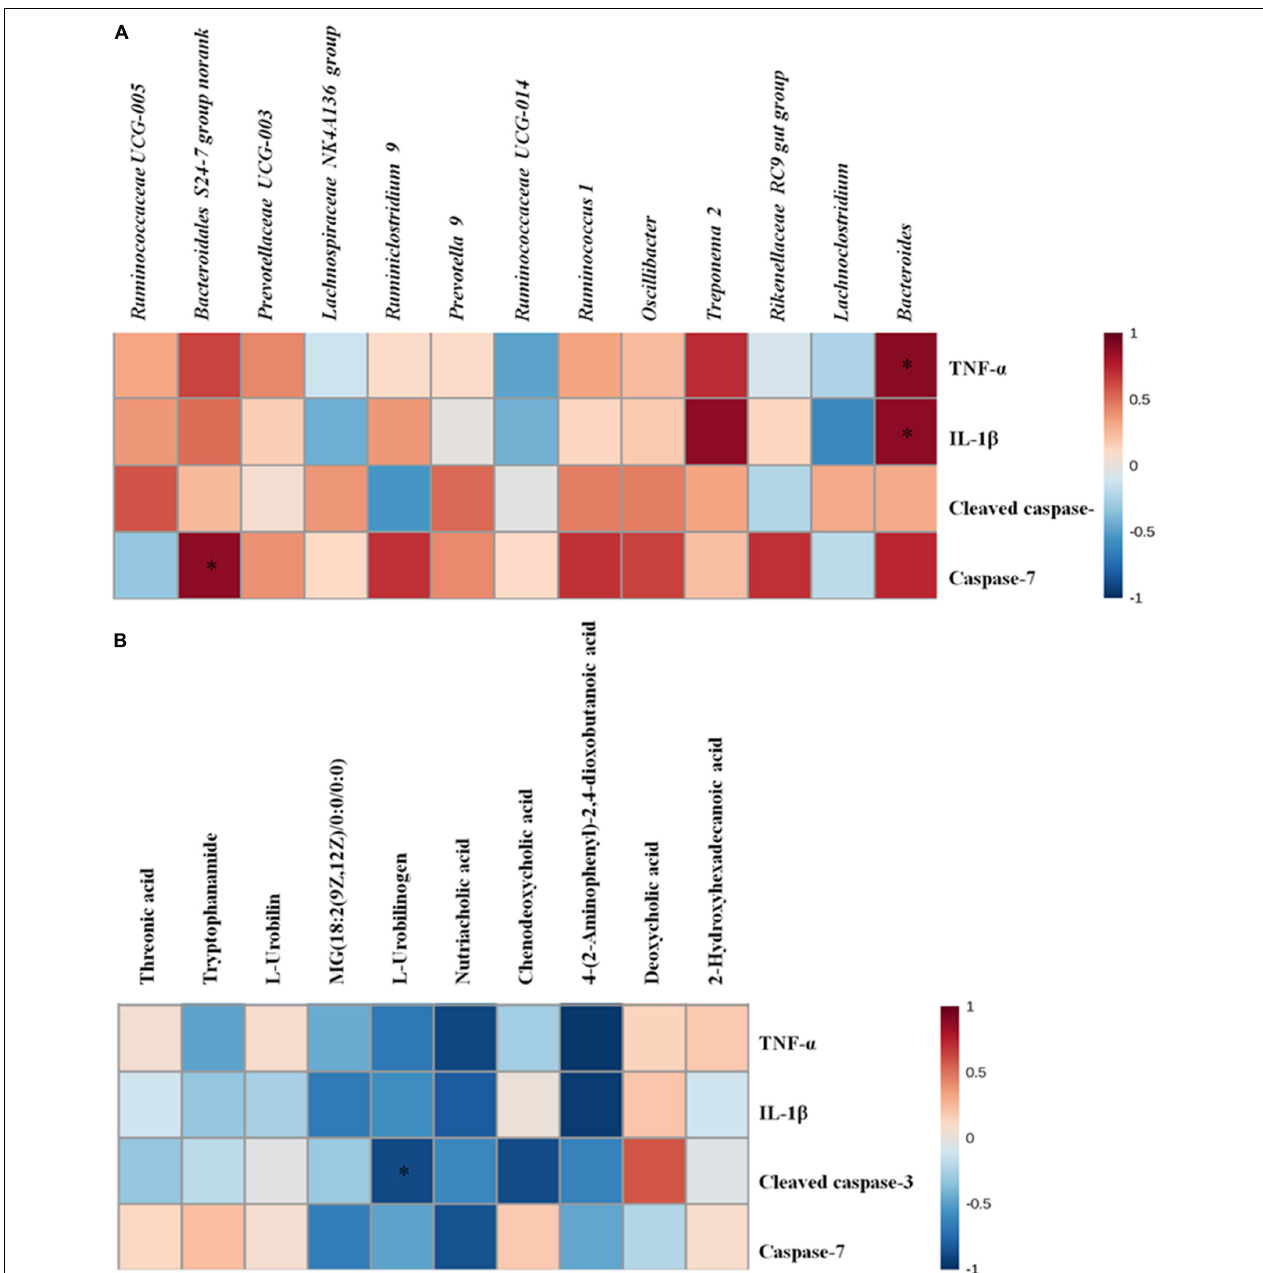
FIGURE 6 | (A) The altered gut microbiota exhibit correlations with over-expressed inflammatory factors and apoptosis proteins. (B) The cecal biomarkers exhibit correlations with over-expressed inflammatory factors and apoptosis proteins. Correlation heat map of altered cecal microbiota genera/disturbed cecal metabolites and over-expressed inflammation factors and apoptosis proteins between the control and model groups; ∗ p < 0.05, ∗∗ p <